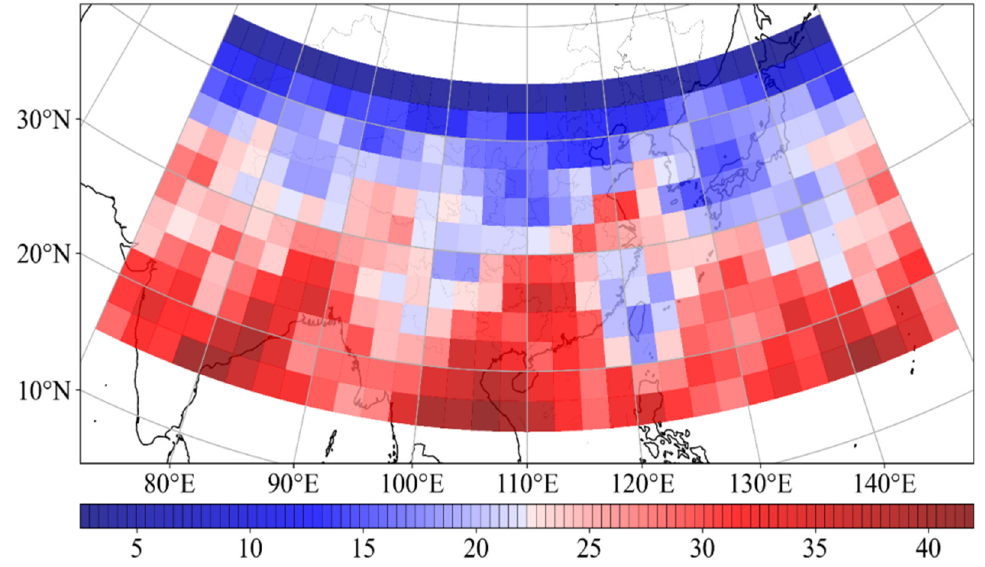
Figure 1. Monthly mean sampling density (unit: number of samples) of COSMIC-2 dry temperature profile data from December 2019 to November 2021 with a grid resolution of 2.5° × 2.5°.